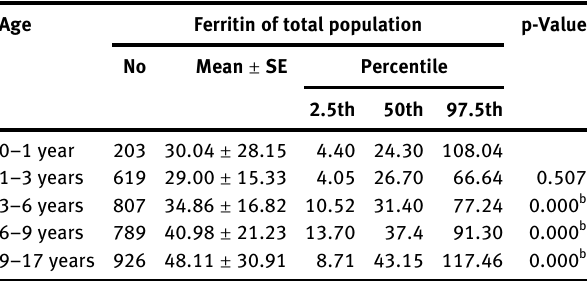
Table  : Serum concentration of ferritin in total population. a